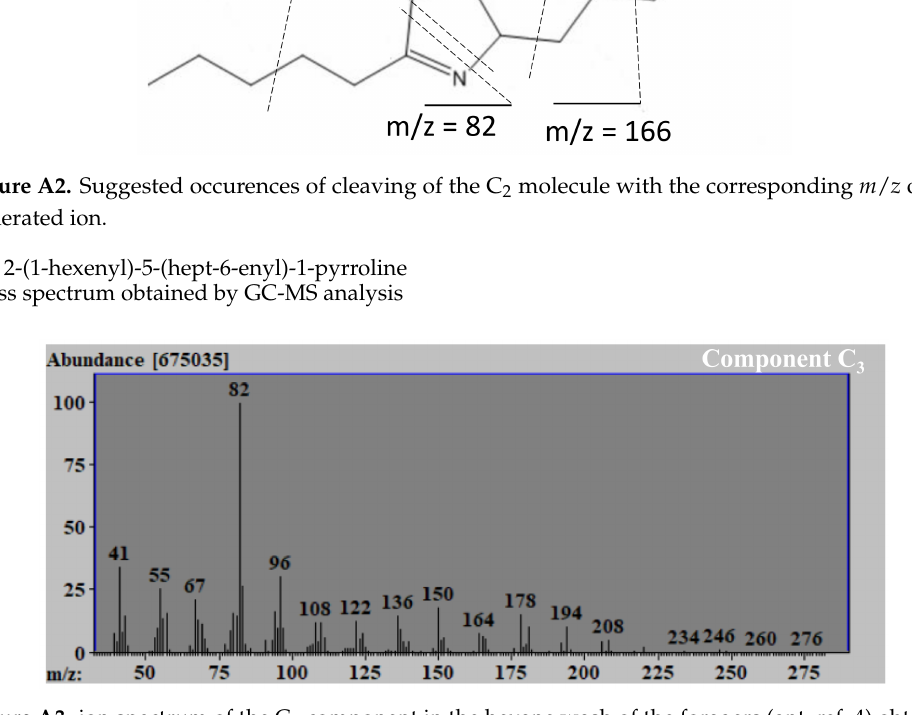
Figure A3. ion spectrum of the C 3 component in the hexane wash of the foragers (ant_ref_4) obtained by GC-MS